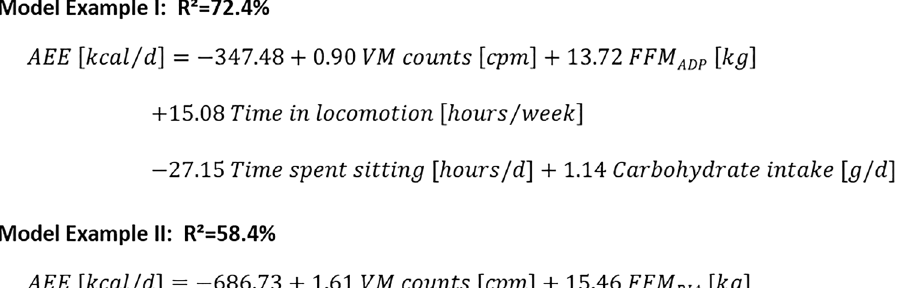
Figure 1. Examples of AEE prediction models when information about accelerometry, ADP, QUAP and nutrition is available (Example I, Table 4 model No. 5), and when only information about accelerometry and BIA is available (Example II, Table 4 model No. 13). More details in Supplementary Table S5. ADP air- displacement plethysmography, AEE activity-related energy expenditure, BIA bioelectrical impedance analysis, FFM fat-free mass, cpm counts per minute, PA physical activity, VM vector